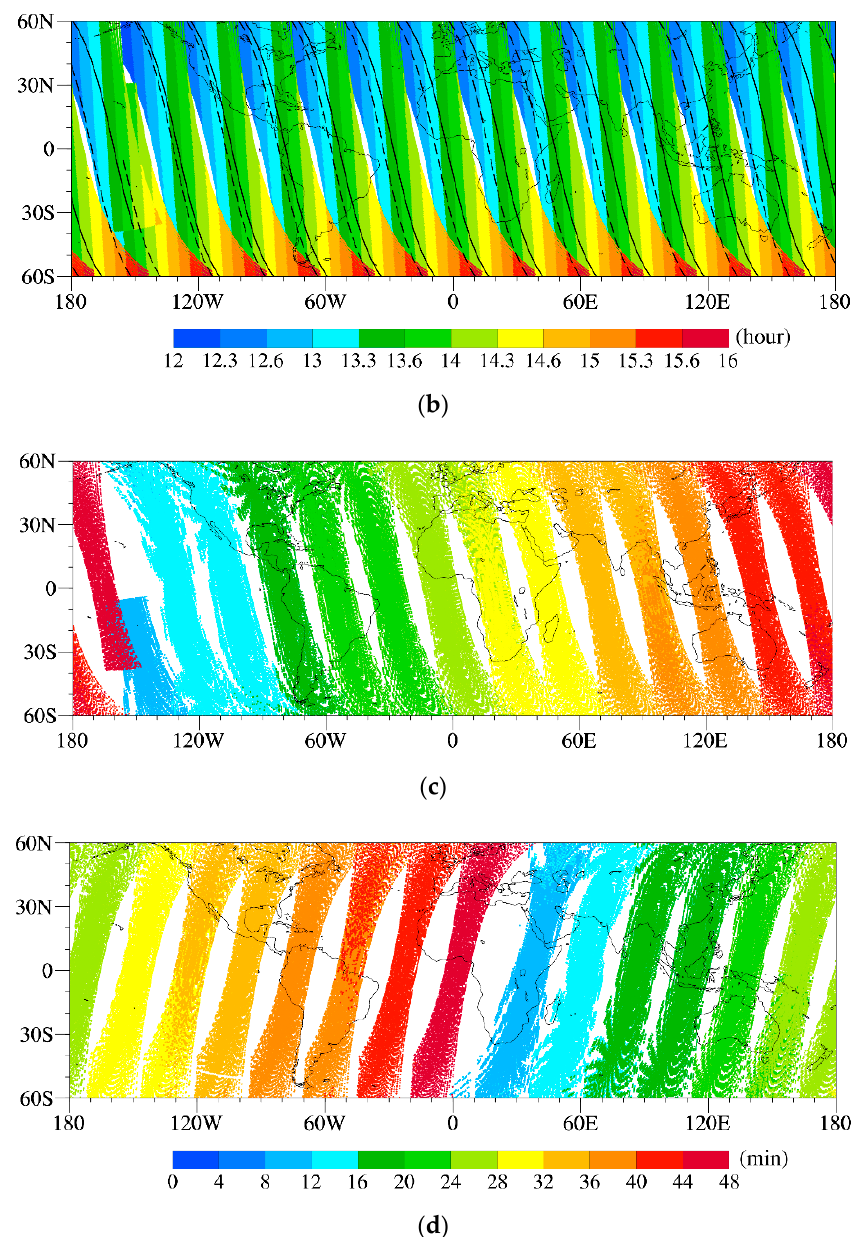
Figure 8. Local time distributions of ( a ) MODIS and ( b ) HIRAS from ascending nodes and time difference between them from ( c ) ascending nodes and ( d ) descending nodes during 0000–2400 UTC 1 January 2019. The black lines in ( b ) are the tracks of the MODIS (dashed) and HIRAS (solid). While ensuring enough data volume, the clear-sky selection will be more accurate if the observation time difference is smaller. Based on the discussion above, the collocation criterion on the observation time difference between HIRAS and MODIS data used in this study is less than 16 min.